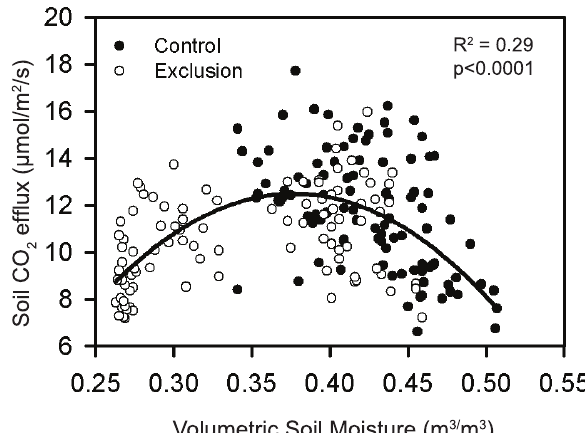
Figure 4. Regression between mean daily volumetric soil moisture and mean daily soil CO 2 efflux in both the control (solid circles) and exclusion (open circles) plots. The equation for the regression is f=y 0 + a * x + b * x 2 .